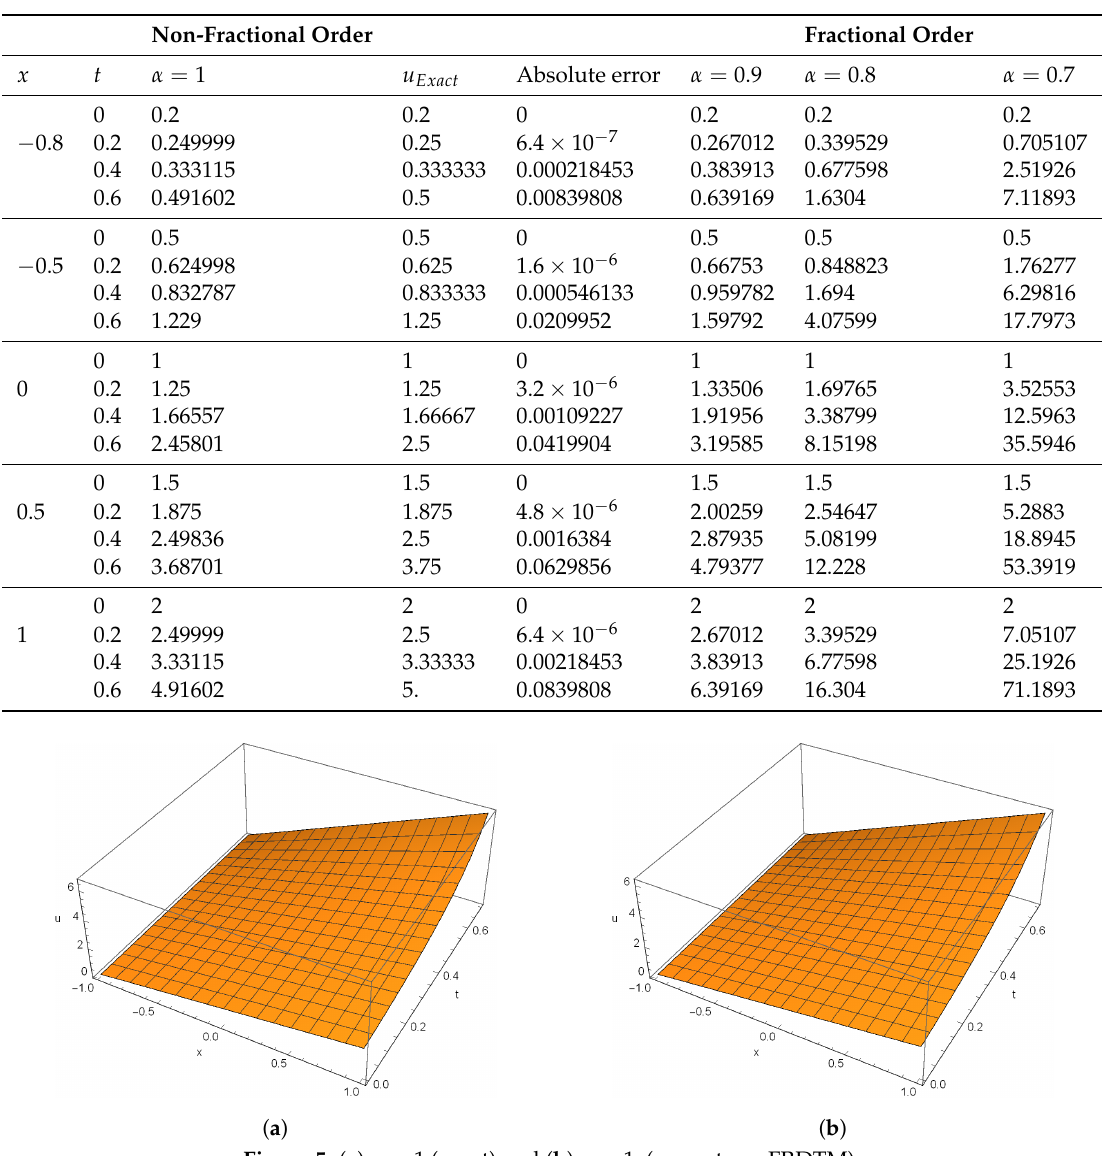
Figure 5. ( a ) α = 1 (exact) and ( b ) α = 1 (seven term